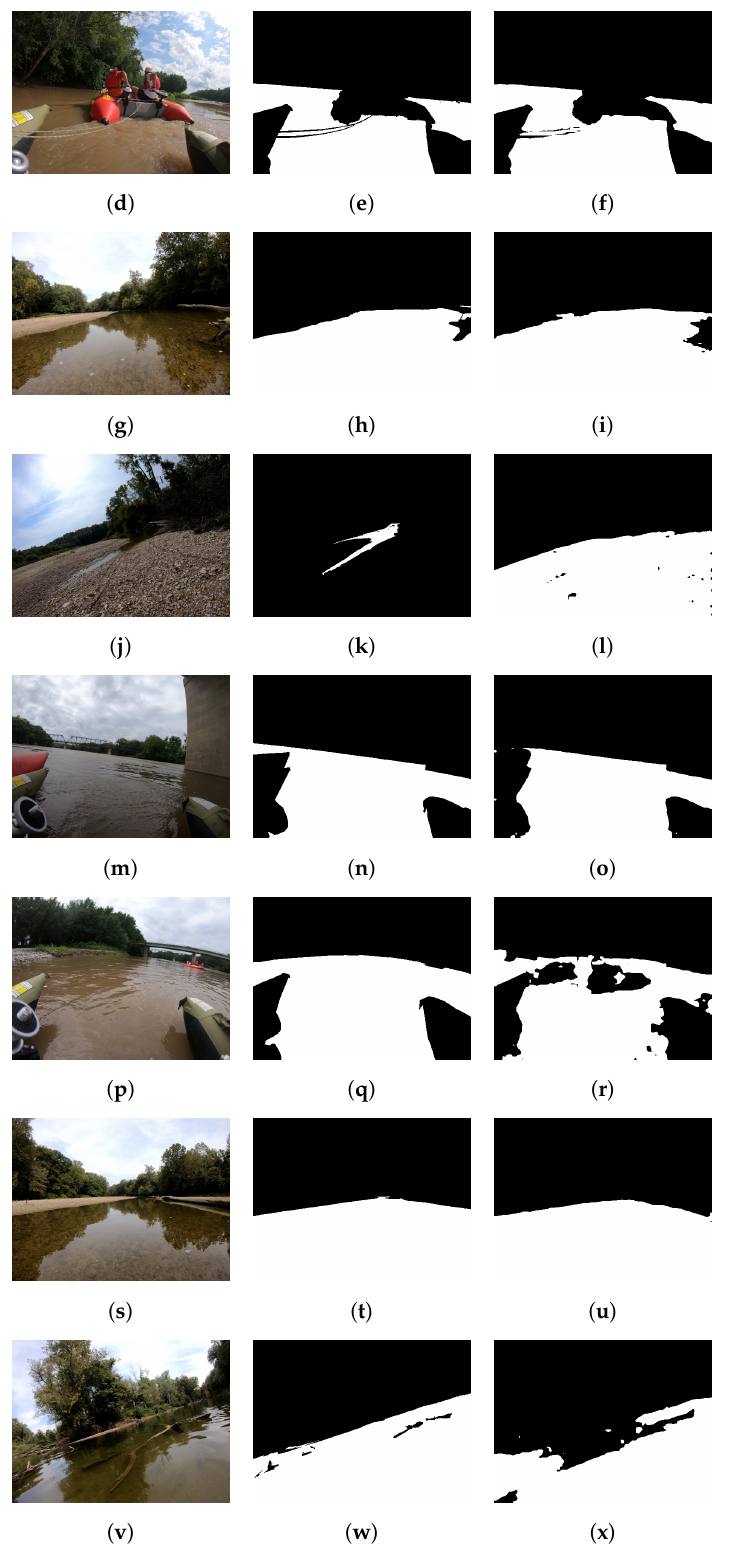
Figure 5. Qualitative outputs of Wasr and WODIS_Xcept networks on the ROSEBUD dataset [38] after completion of training as detailed in Section 4.4. From left to right, the columns show the test image, ground truth annotation, and the output mask by the network. Images ( a – l ) are WaSR Network Outputs, while ( m – x ) are WODIS_Xcept network